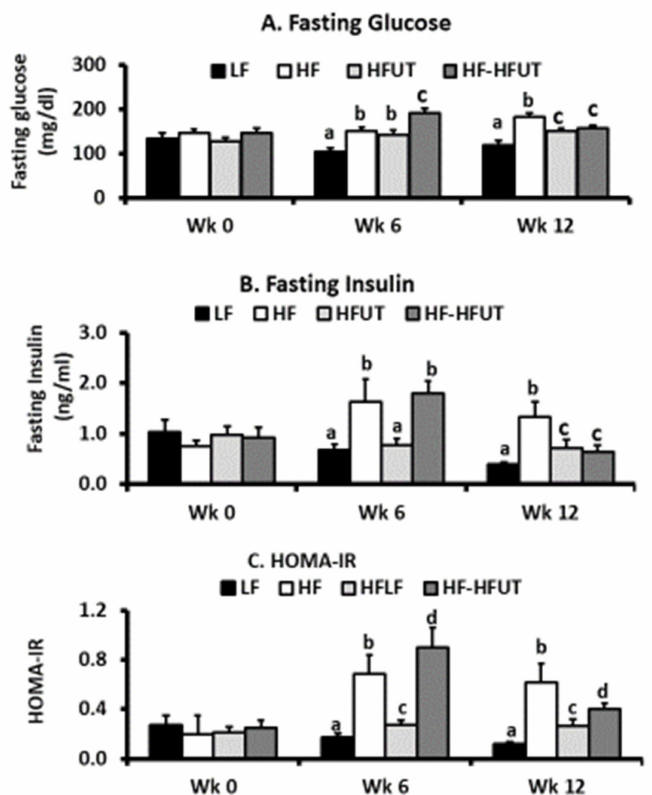
Figure 2. Supplementation with U. dioica vegetable reduced fasting glucose, fasting insulin, and enhanced insulin sensitivity. Fasting glucose and fasting insulin were determined by glucometer and ELISA test respectively. ( A ) At week 0 (baseline), all groups had similar fasting glucose. By week 6 the HF diet induced higher fasting glucose and UT had no e ff ect. By week 12, the HF fed group had the highest fasting glucose and UT vegetable induced significantly lower glucose levels in group 3 (fed UT for 12 weeks) and group 4 (fed UT for 6 weeks) compared to HF group ( p < 0.05; n = 8–9). ( B ) At baseline, all groups had similar fasting Insulin. By week 6 the HF diet induced higher fasting glucose in the two groups and group 3 fed with UT had significantly lower insulin levels compared to the HF group. By week 12, the HF fed group had the highest fasting glucose and UT vegetable induced significantly lower insulin levels in group 3 (fed UT for 12 weeks) and group 4 (fed UT for 6 weeks) compared to HF group ( p < 0.05; n = 8–9). ( C ) At baseline, all groups had similar HOMA-IR values. By week 6, the HF diet induced higher HOMA-IR and group 3 fed with UT had significantly lower HOMA-IR ( p < 0.001; n = 8–9). By week 12, the HF fed group had the highest HOMA-IR and UT vegetable induced significantly lower insulin levels in group 3 (fed UT for 12 weeks) and group 4